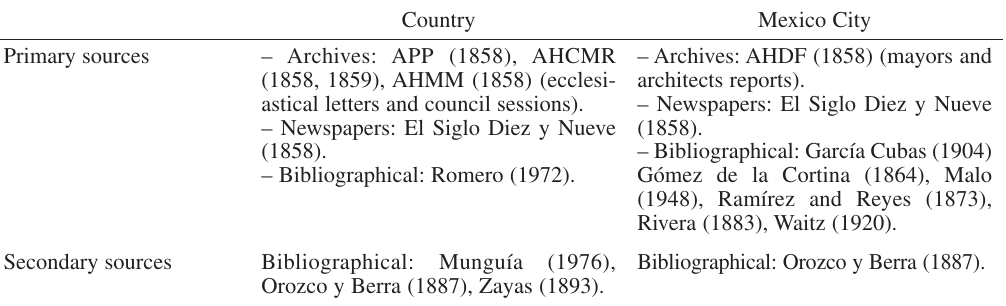
Table IV. Sources for the 1858